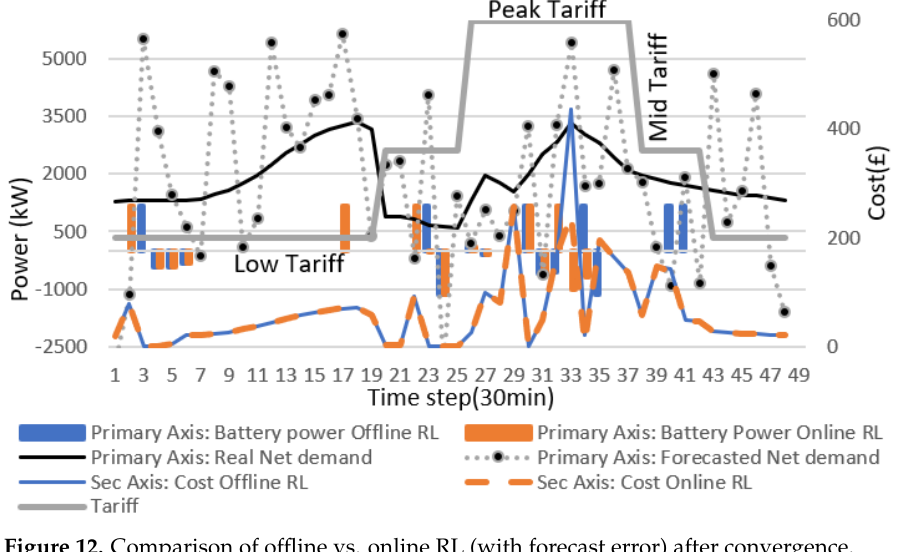
Figure 12. Comparison of offline vs. online RL (with forecast error) after convergence.